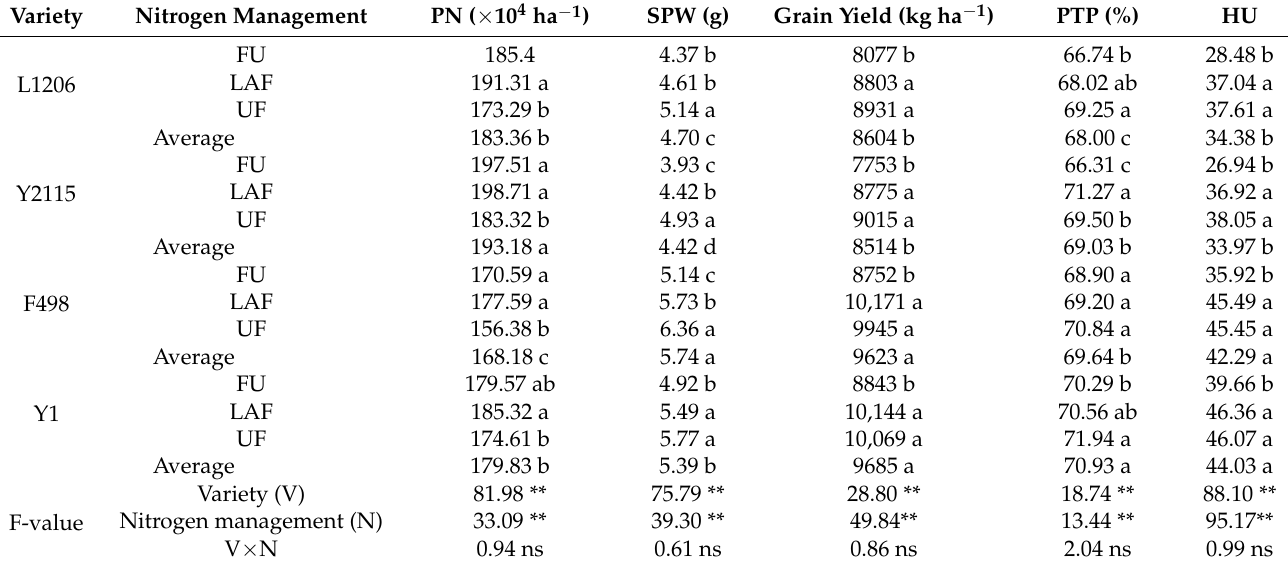
Table 5. Effects of nitrogen management on grain yield components and heading traits in 2019 and 2020 (two-year average). Variety Nitrogen